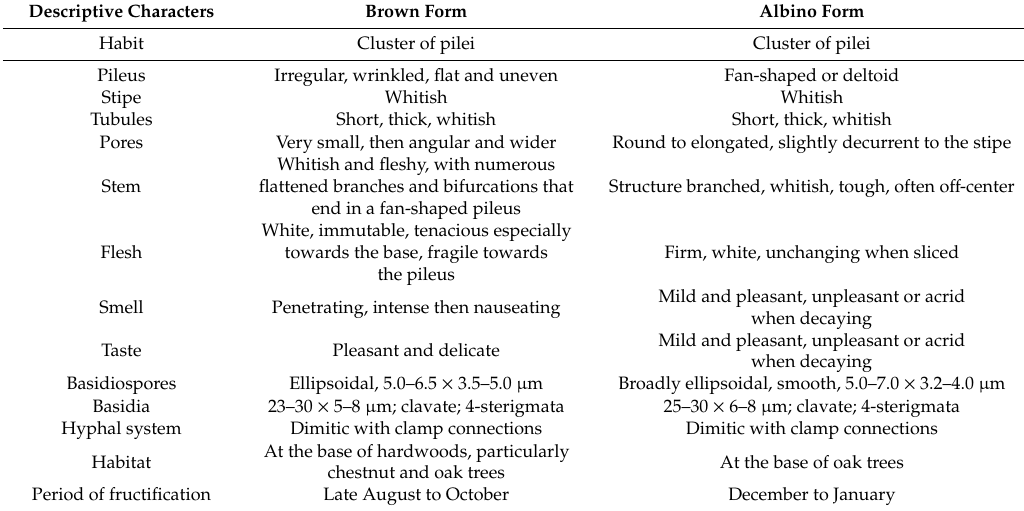
Figure 2. ( a ) Microscopic features (basidia and spores) of albino maitake. ( b ) Pure culture isolated from fresh basidioma. Table 1. Main macro- and micromorphological features of brown [7,17] and albino (this study) forms of